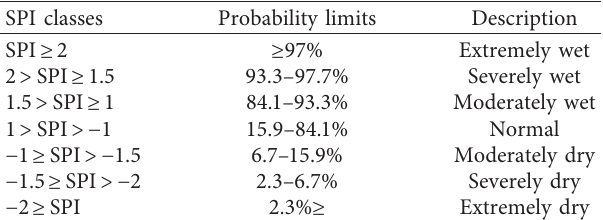
Table 2: Classification of the SPI’s values and corresponding probability limits [1,